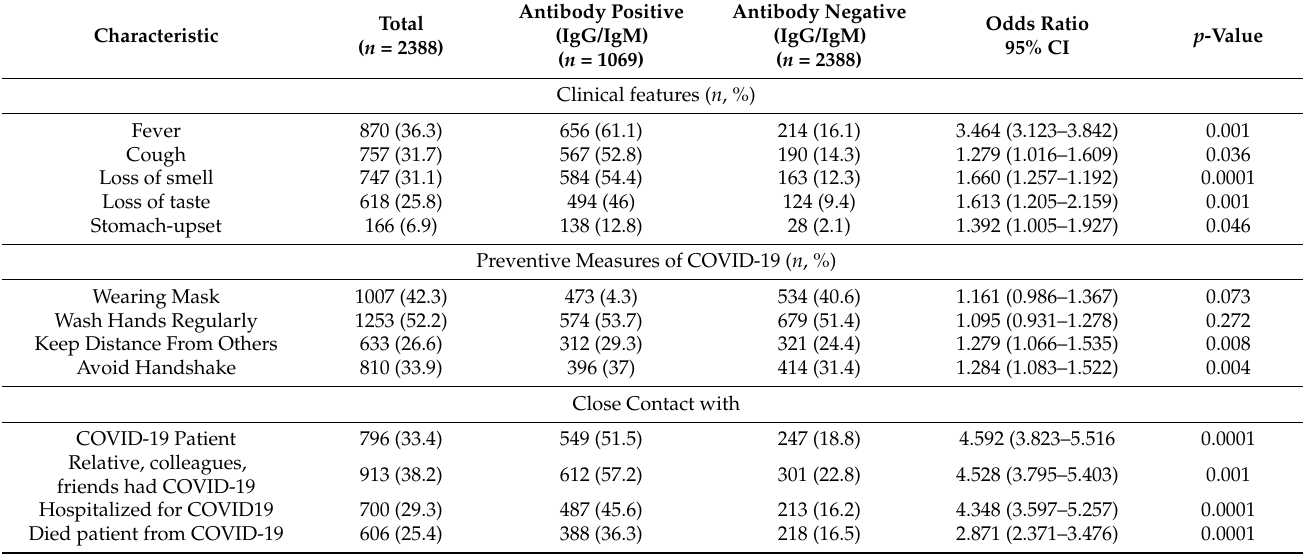
Table 3. Clinical features, preventive measures and COVID-19 status.